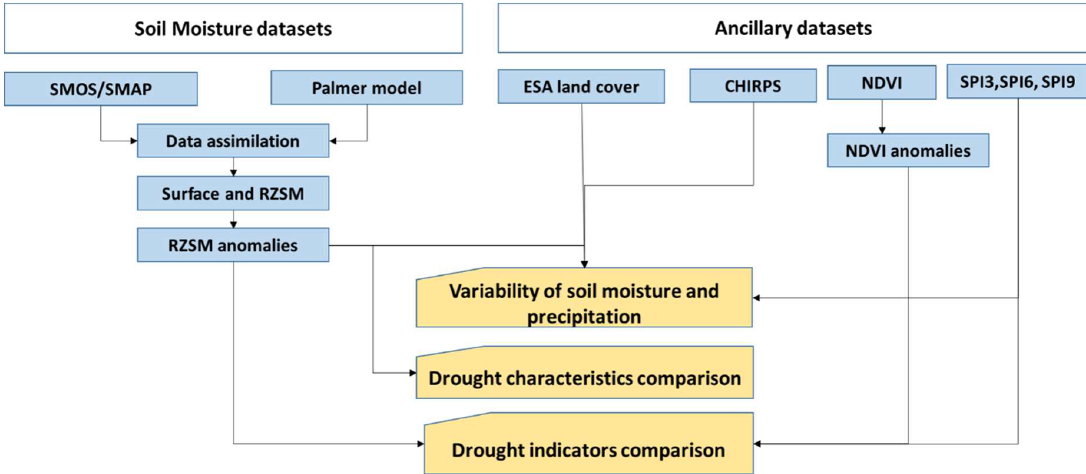
Figure 1 . Schematic overview of the methodological approach. SMOS, Soil Moisture Ocean Salinity mission; SMAP, Soil Moisture Active Passive mission; ESA, European Space Agency; CHIRPS; Climate Hazards Group Infrared Precipitation with Station; NDVI, Normalized Difference Vegetation Index; SPI, Standardized Precipitation Index; and RZSM, root zone soil moisture. Table 1 . Datasets used in this study.